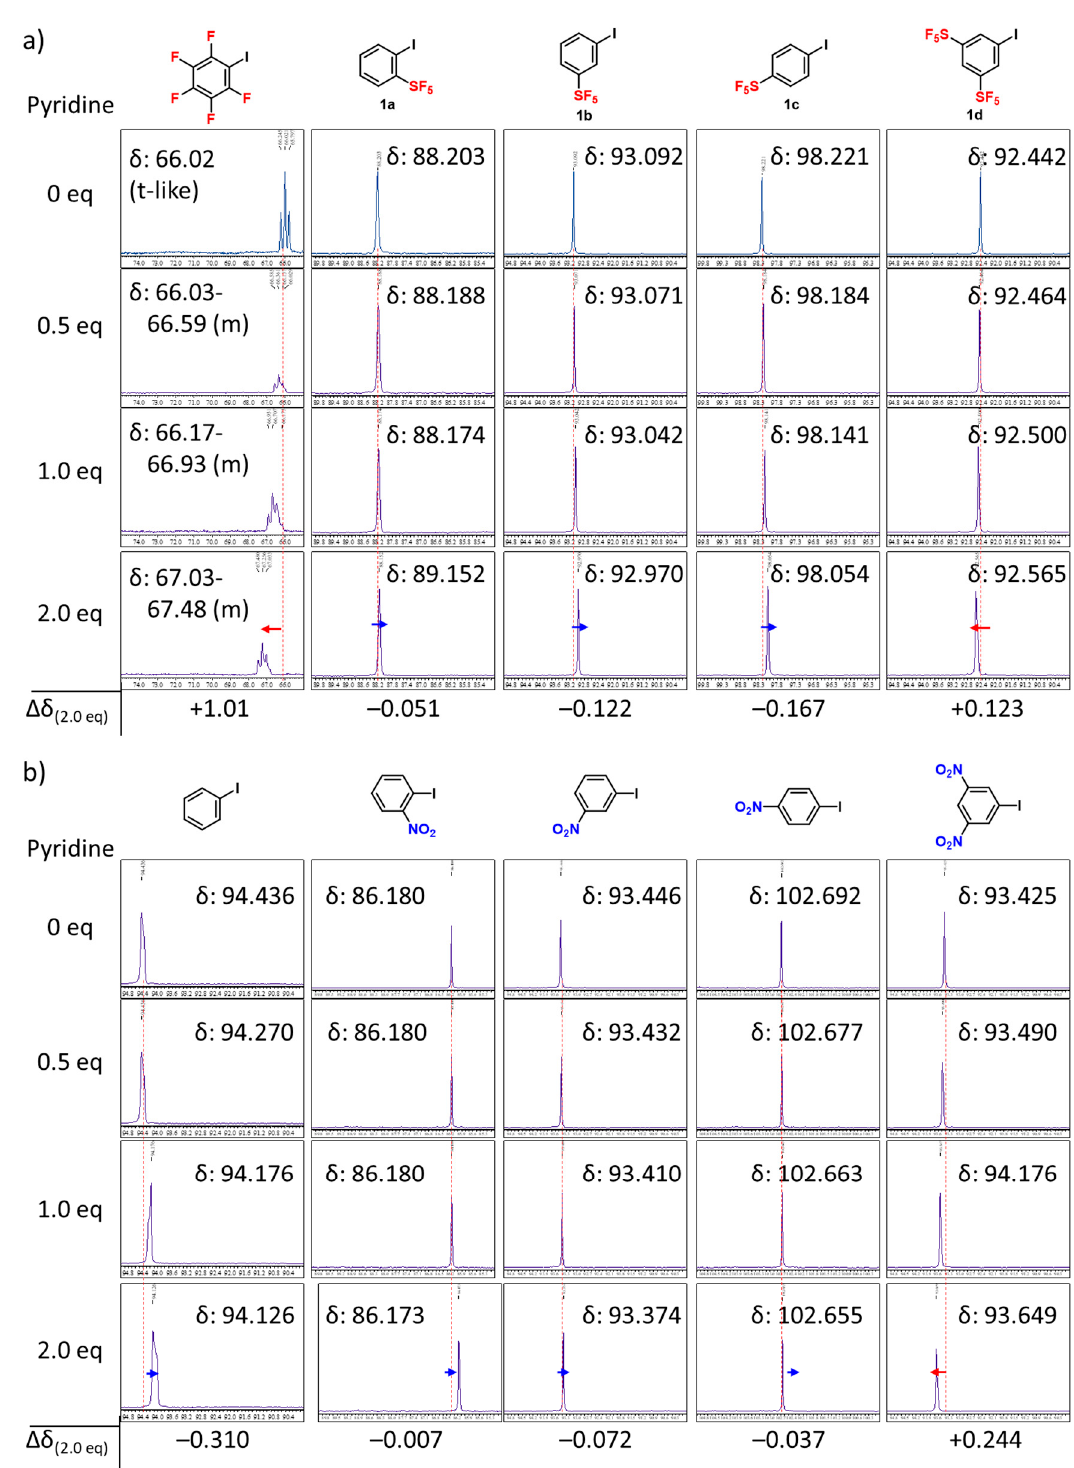
Figure 4. Change in the 13 C-NMR chemical shift of the carbon atom bonded to iodine in Ar − I with equivalents of pyridine in CDCl 3 . ( a ) pentafluoro-iodobenzene; o -SF 5 -iodobenzene ( 1a ); m -SF 5 -iodobenzene ( 1b ); p -SF 5 -iodobenzene ( 1c ); 3,5-bis-SF 5 -iodobenzene ( 1d ). ( b ) iodobenzene; o -NO 2 -iodobenzene; m -NO 2 -iodobenzene; p -NO 2 -iodobenzene; 3,5-bis-NO 2 -iodobenzene.